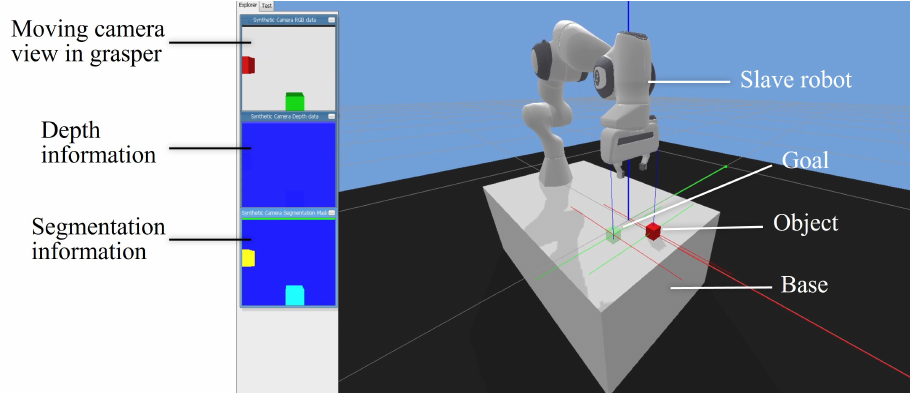
Figure 6. GUI for the teleoperation system. The interface was divided into a display area and an operation area. The three windows in the display area ( left panel) presented the visual feedback of gripper’s camera in top view, depth information and segmentation information, respectively. The operation area ( right panel) showed the operation robot in perspective view under a global